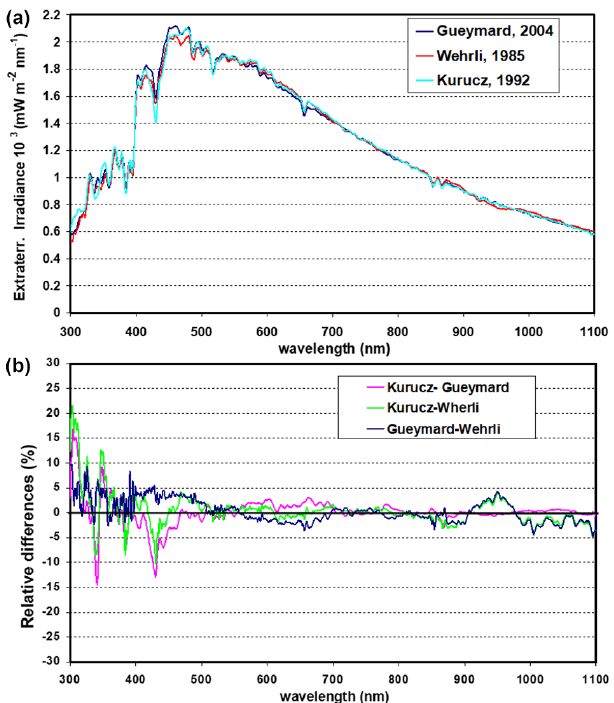
Figure 10. Comparison between the extraterrestrial solar irradiance spectra given by Gueymard, Wehrli, and Kurucz (see references) convoluted with a spectral triangular slit function of FWHM of